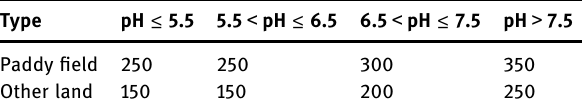
Table 1: Limit of Cr content in agricultural soil ( mg · kg − 1 )